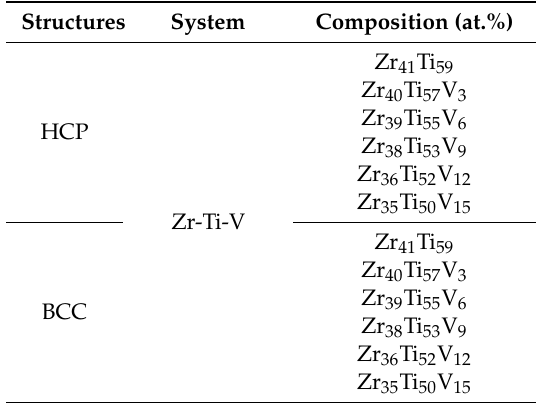
Table 2. Zr-Ti-V alloy systems in HCP structure and BCC structure with di ff erent atomic fraction of